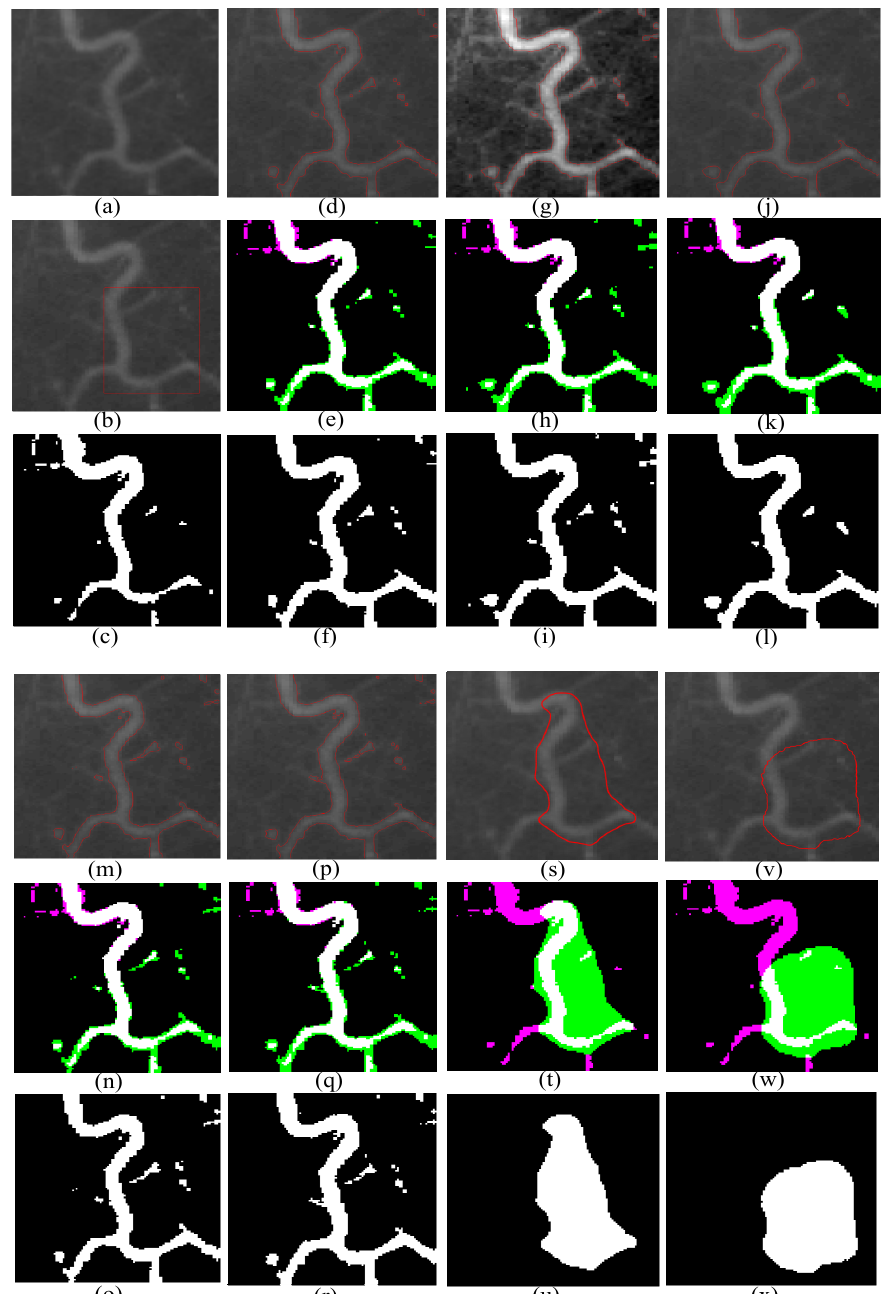
Figure 5. Performance of our method, the LIC model, the LBF model, 0.5-order, 1.5-order, the CV model and the ALFB model. ( a ) Original image; ( b ) the original image with the initial contour; ( c ) the ground truth of the original image; ( d ) the segmentation result of our method; ( e ) the comparison map of our method; ( f ) the ground truth of our method; ( g ) the segmentation result of LIC model; ( h ) the comparison map of LIC model; ( i ) the ground truth of LIC model; ( j ) the segmentation result of LBF model; ( k ) the comparison map of LBF model; ( l ) the ground truth of LBF model; ( m ) the segmentation result of 0.5-order; ( n ) the comparison map of 0.5-order; ( o ) the ground truth of 0.5-order; ( p ) the segmentation result of 1.5-order; ( q ) the comparison map of 1.5-order; ( r ) the ground truth of 1.5-order; ( s ) the segmentation result of CV model; ( t ) the comparison map of CV model; ( u ) the ground truth of CV model; ( v ) the segmentation result of ALFB model; ( w ) the comparison map of ALFB model; and ( x ) the ground truth of ALFB